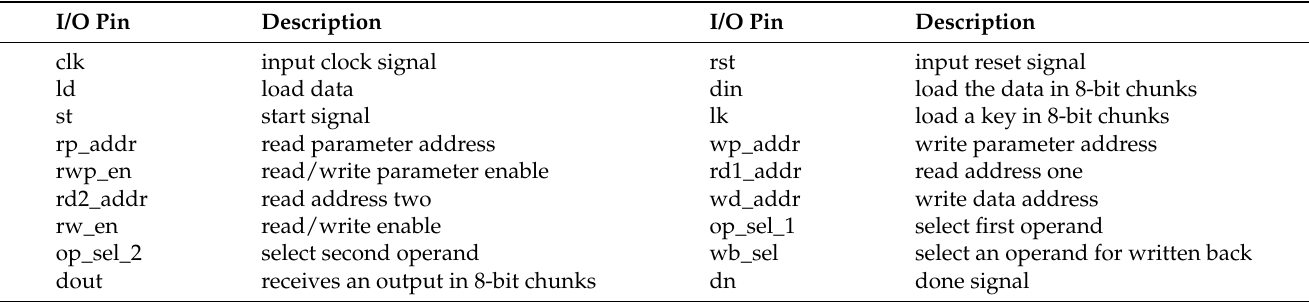
Table 1. Description of the I/O pins and control signals of our proposed PM